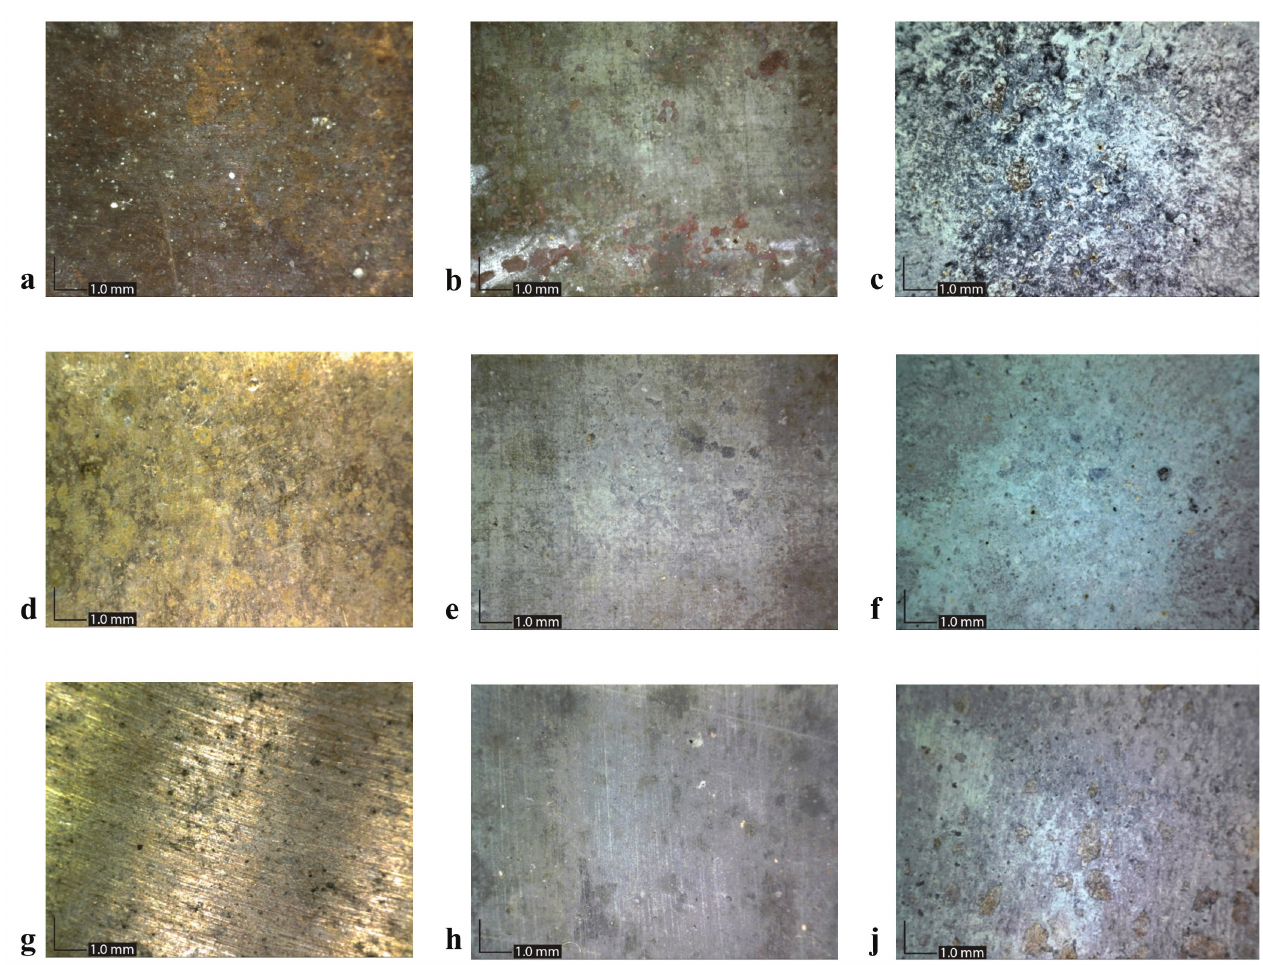
Fig. 5 – Optical microscopy images of studied samples after 24 weeks of exposure to outdoor atmosphere: a) blank Cu, b) AP Cu, c) NP Cu, d) blank CuSn6, e) AP CuSn6, f) NP CuSn6, g) blank CuSn9Zn2Pb, h) AP CuSn9Zn2Pb, j) NP